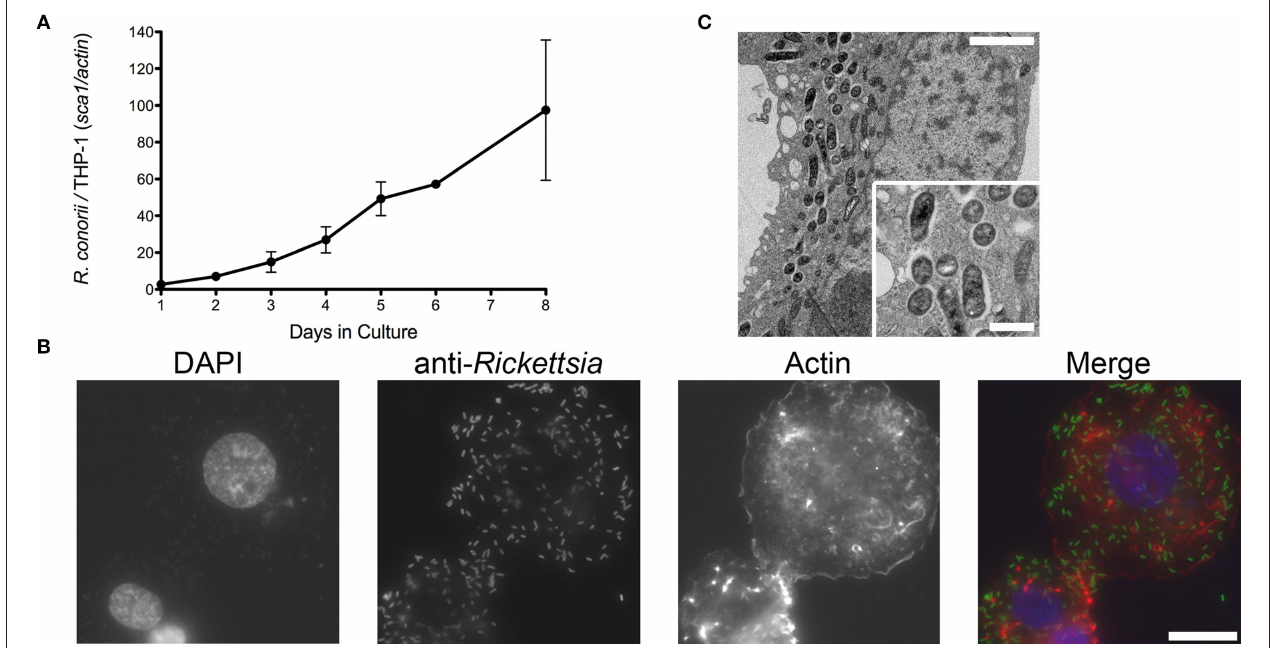
FIGURE 1 | Ability of R. conorii to invade and proliferate within THP-1-derived macrophages. (A) PMA-differentiated THP-1 cells were infected with R. conorii and genomic DNA was extracted at different time-points after infection. Quantitative PCR data are expressed as the ratio of R. conorii sca1 vs. actin DNA content. (B) Immunofluorescence microscopy of THP-1-derived macrophages cells infected with R. conorii at 3 days post-infection. Cells were stained with DAPI (blue) to identify host nuclei, Phalloidin (red) to stain actin and anti- Rickettsia antibody (RcPFA) followed by Alexa Fluor 488 (green) to identify R. conorii . Scale bar = 10 µ m. (C) Ultrastructure of THP-1-derived macrophages after 5 days post inoculation with R. conorii by TEM. Scale bar = 2 µ m (top) and 500 nm (bottom).